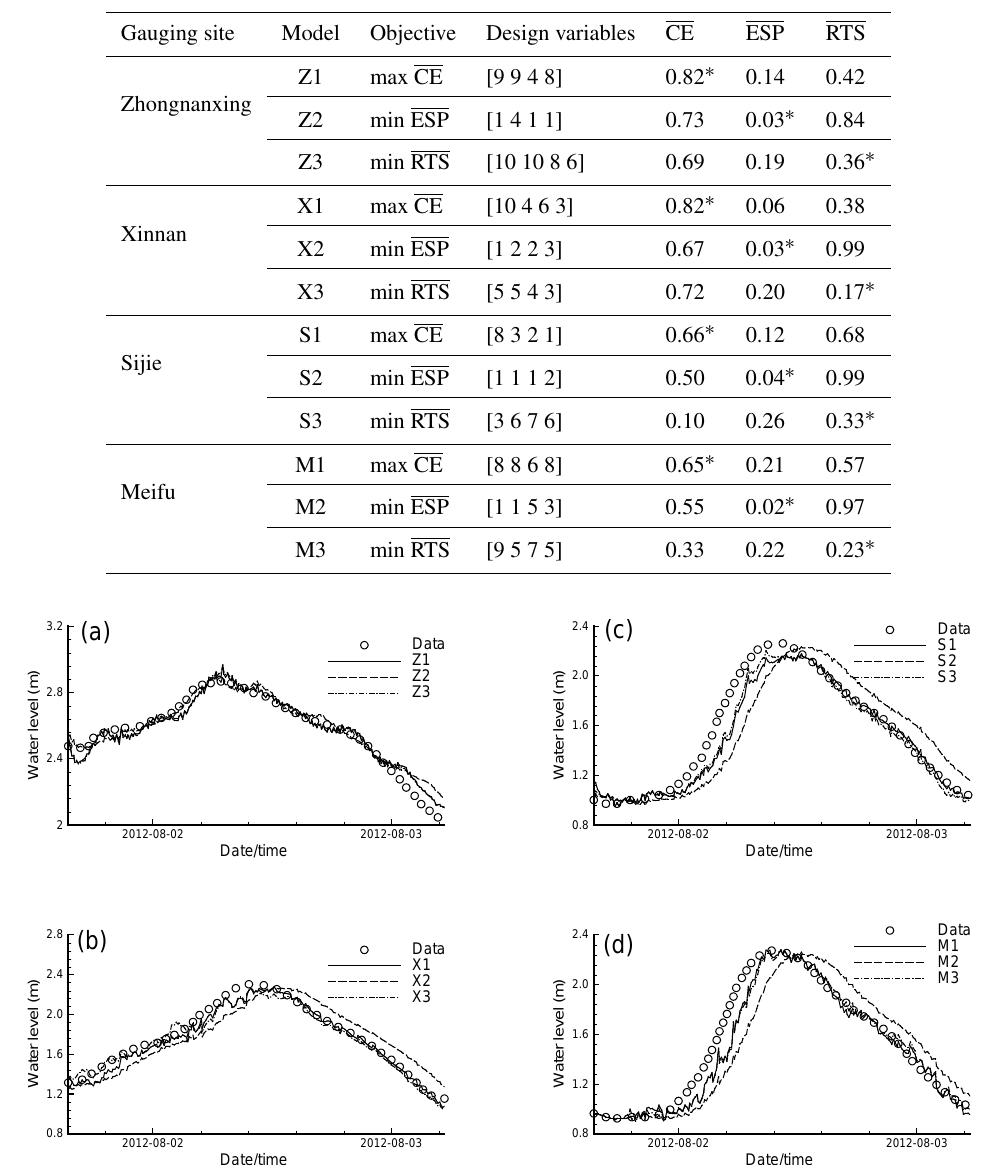
Table 6. Models selected from the Pareto optimal model set using the best scores for each of the three objectives ( ∗ best score).